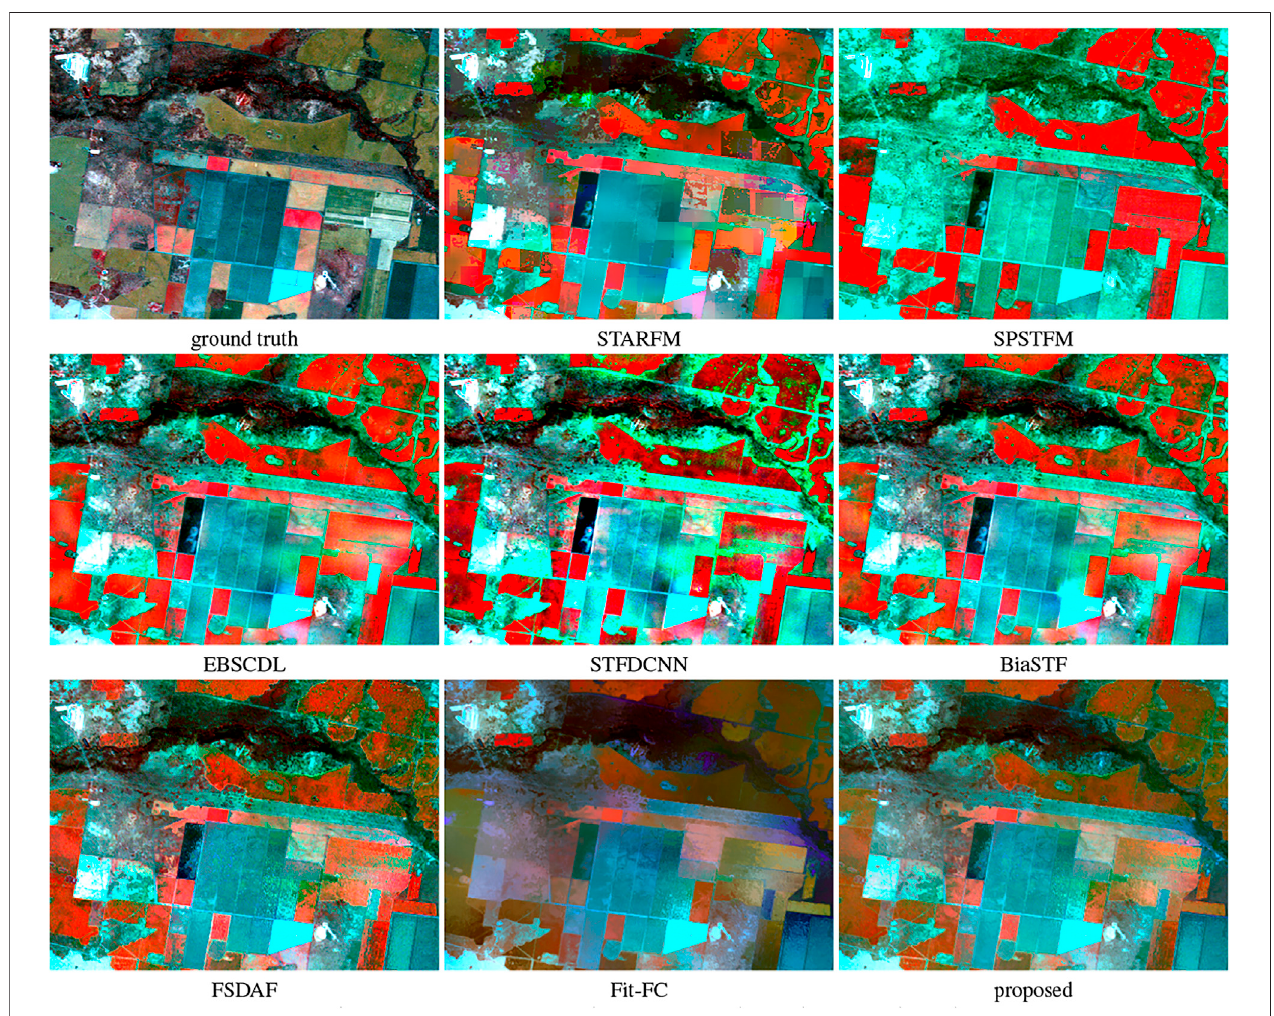
FIGURE 3 | Manifestation of the small region of the NIR, red, and green bands of LGC image 2 for detail observation.